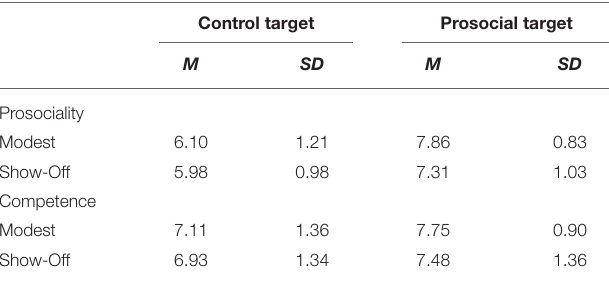
TABLE 5 | Mean target prosociality and competence ratings per condition in Experiment 2.